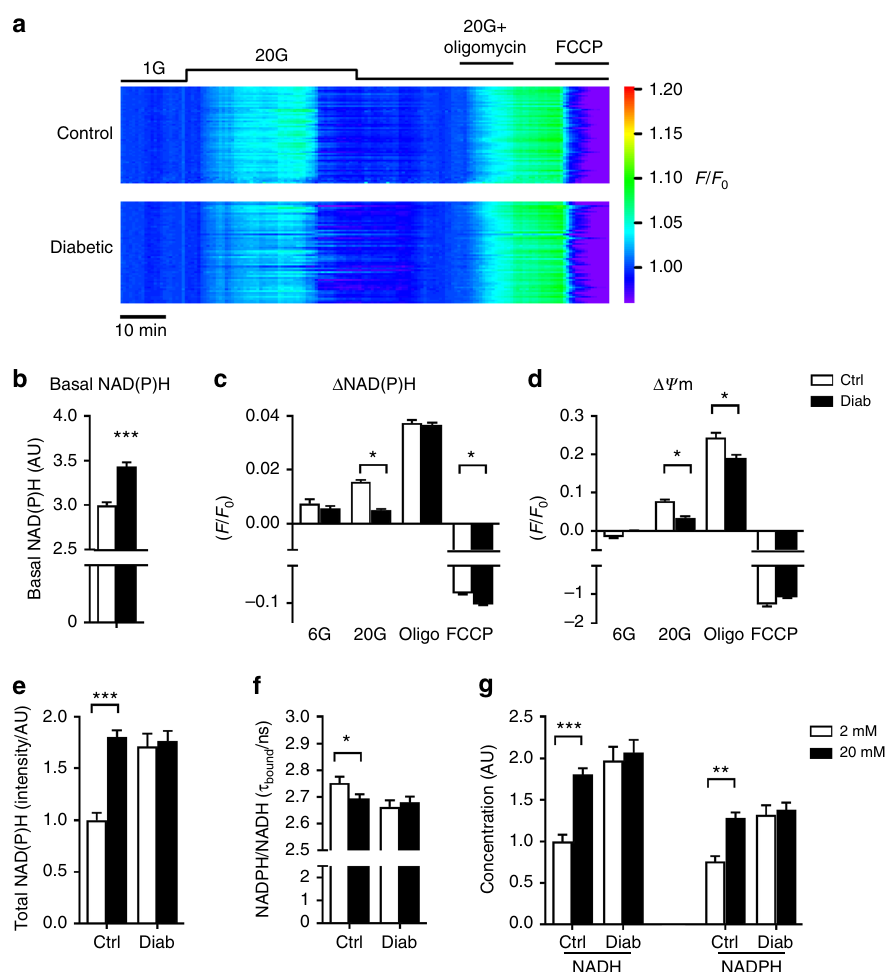
Fig. 4 Diabetes alters islet NAD(P)H generation. a Relative change in NAD(P)H fl uorescence ( F / F 0 ) recorded simultaneously in groups of control (above, n = 58) or 2-week diabetic β V59M (below, n = 54) islets. Each trace represents an individual islet. Data are colour coded according to a ‘ rainbow ’ LUT, i.e. from violet (low value) to red (high value). b Basal NAD(P)H auto fl uoresence at 2mM glucose in control (white, n = 396 islets) and 2-week diabetic islets (black, n = 200 islets). Mean±s.e.m., t test *** p <0.001. c Change in NAD(P)H auto fl uoresence in response to glucose (6 or 20mM), to 20mM glucose + 10 µ M oligomycin and to 20mM glucose + 4 µ M FCCP in control (white, n = 60 – 257 islets) and 2-week diabetic β V59M islets (black, n = 152 – 194 islets). d Change in mitochondrial membrane potential, as assessed by TMRE (tetramethylrhodamine ethyl ester) fl uorescence, in response to glucose (6 or 20mM), to 20mM glucose + 10 µ M oligomycin and to 20mM glucose + 4 µ M FCCP in control (black, n = 83 – 199 islets) and 2-week diabetic islets (red, n = 111 – 248 islets). c , d Data are normalised to the level in 2mM glucose. Mean±s.e.m. Kruskal – Wallis analysis of variance with Dunn post hoc test. * p <0.05. e – g NADH and NADPH auto fl uorescence measured with fl uorescence lifetime imaging microscopy in control ( n = 21) and 2-week diabetic islets ( n = 30) exposed to 2 (white bars) or 20mM (black bars) glucose. Mean±s.e.m. t test * p <0.05, ** p <0.01, *** p <0.001. e NAD(P)H auto fl uorescence. f Fluorescence lifetime of enzyme-bound NADH + NADPH auto fl uorescence signal. g Relative NADH and NADPH (Supplementary Table 1). In contrast, most enzymes of the malate – aspartate shuttle were unchanged, while ARALAR2 (the mitochondrial aspartate – glutamate transporter) and MDH2 (the malate dehydrogenase) were signi fi cantly decreased at the protein level (1.5-fold and 1.9-fold, respectively; Supplementary Table 1).